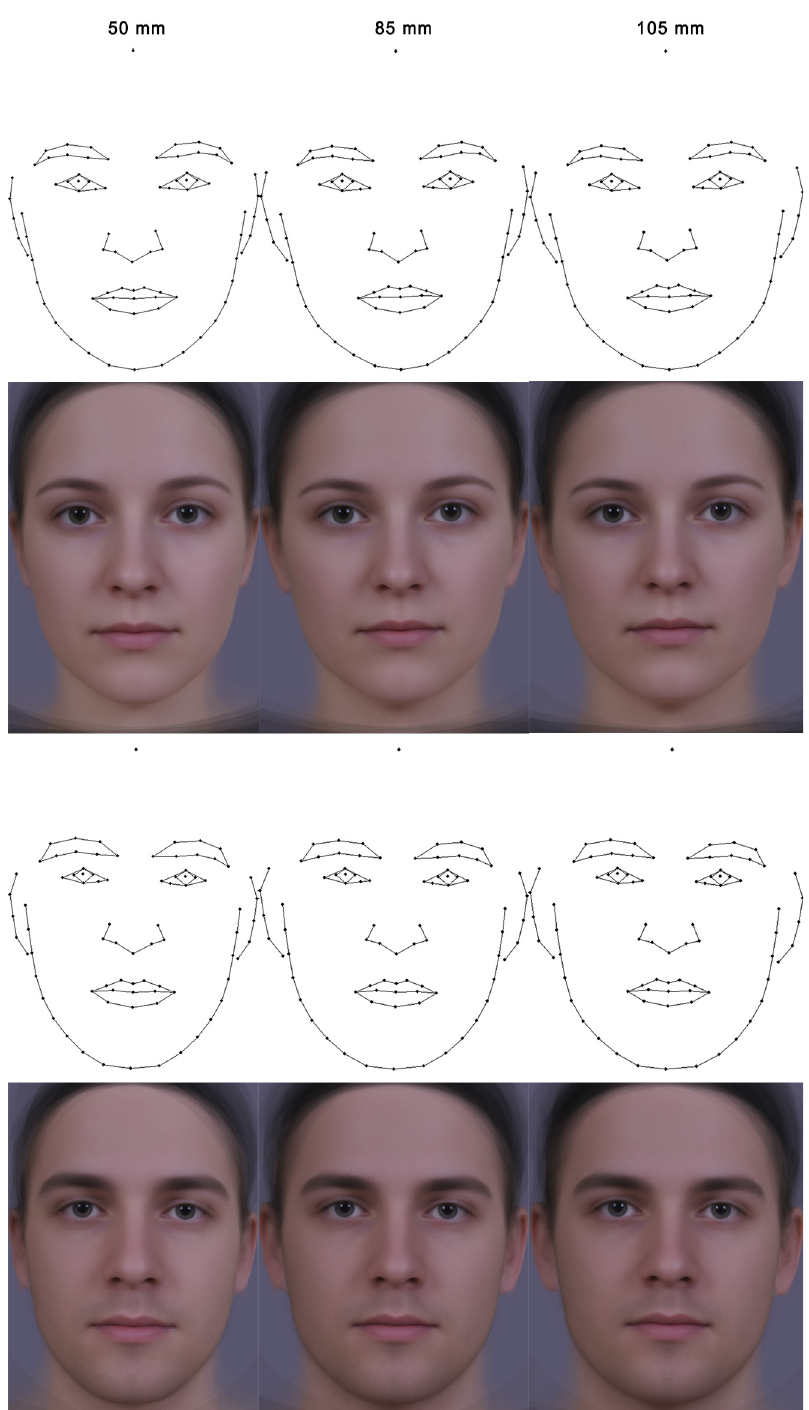
Fig 5. Consensual configurations and composites of female and male images for the 50 mm, 85 mm and 105 mm focal